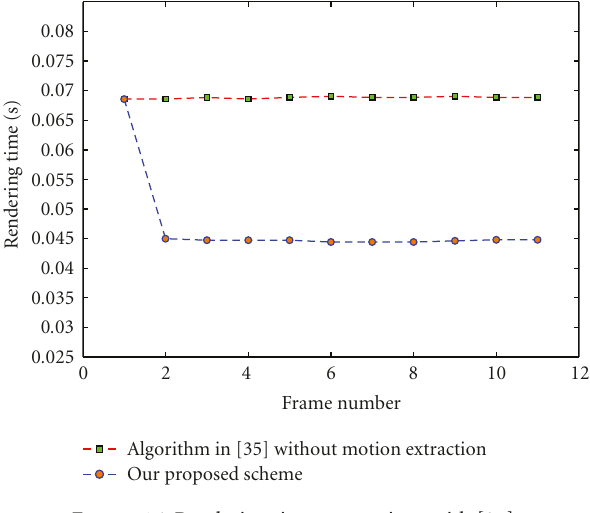
Figure 16: Rendering time comparison with [35]. Table 1: Comparison on rendering image